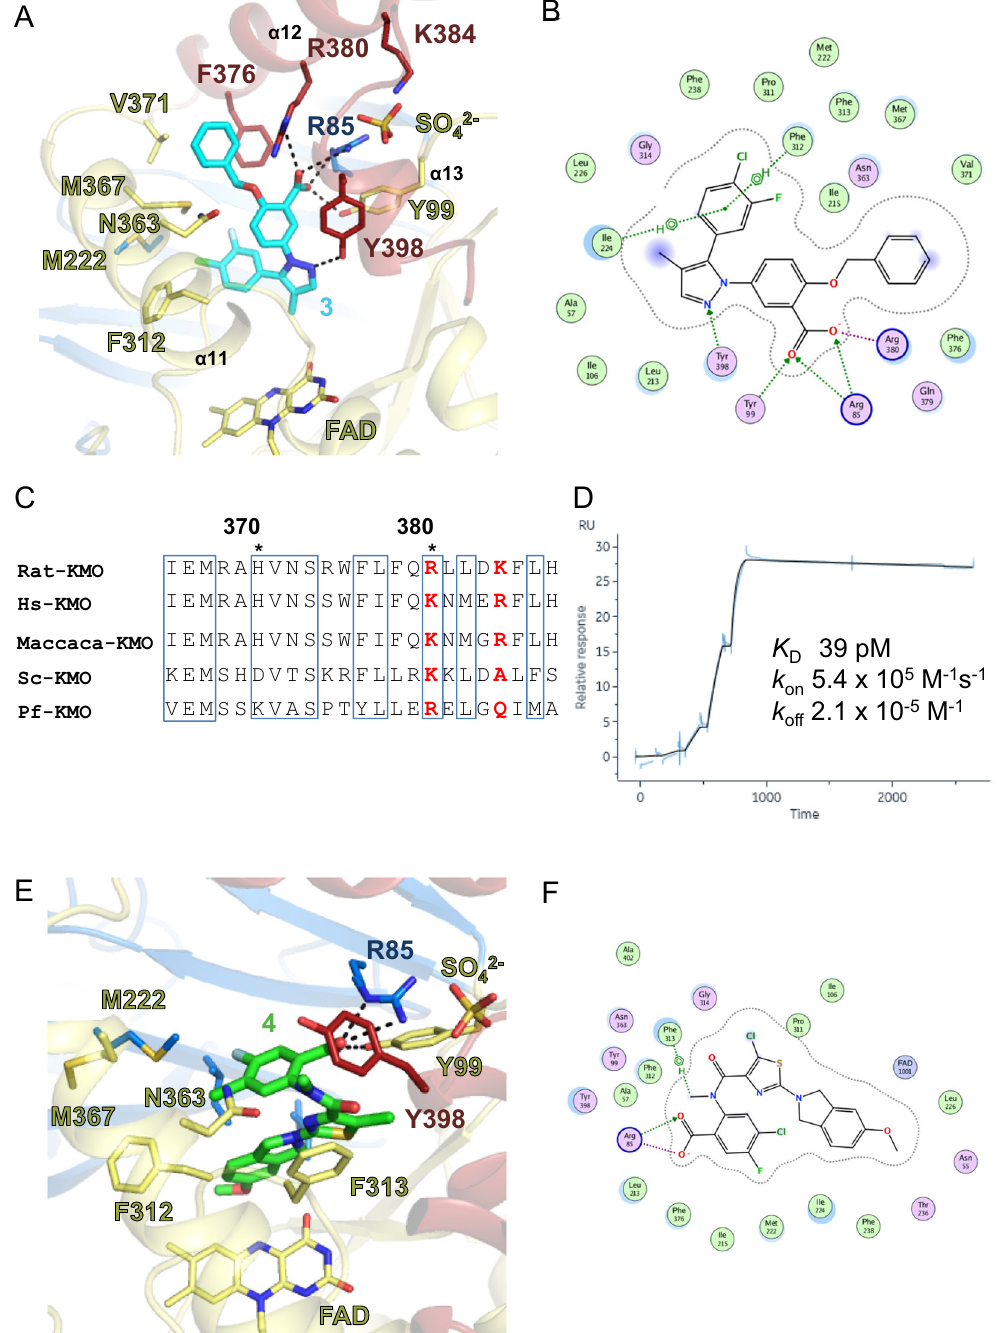
Fig. 3 Ligand-binding pocket of full-length Rat-KMO with inhibitors. A , B Ligand-binding pocket of Rat-KMO inhibited by compound 3 . Residues of α 12 play key roles in compound 3 recognition. Key residues for compound 3 recognition are depicted as sticks. Sticks and secondary structures are coloured using the same scheme as that in Fig. 1. Hydrogen bonds are shown as broken lines. Detailed interactions are shown using MOE software. C Sequence alignment of the KMO C-terminal residues among species. R380 is K380 in human KMO. Discrepancies in the sequence at this region may explain the species differences observed in our pharmacological assays. D Surface plasmon resonance study of compound 3 shows a remarkably low k off value. E , F Crystal structure of Rat-KMO in complex with compound 4 . Y398 was fl ipped to accommodate the methyl group and the isoindoline ring of compound 4 , and protruded into a site perpendicular to and above FAD. Key residues and secondary structures are coloured using the same scheme as that in Fig. 1. Compound 4 is shown as green